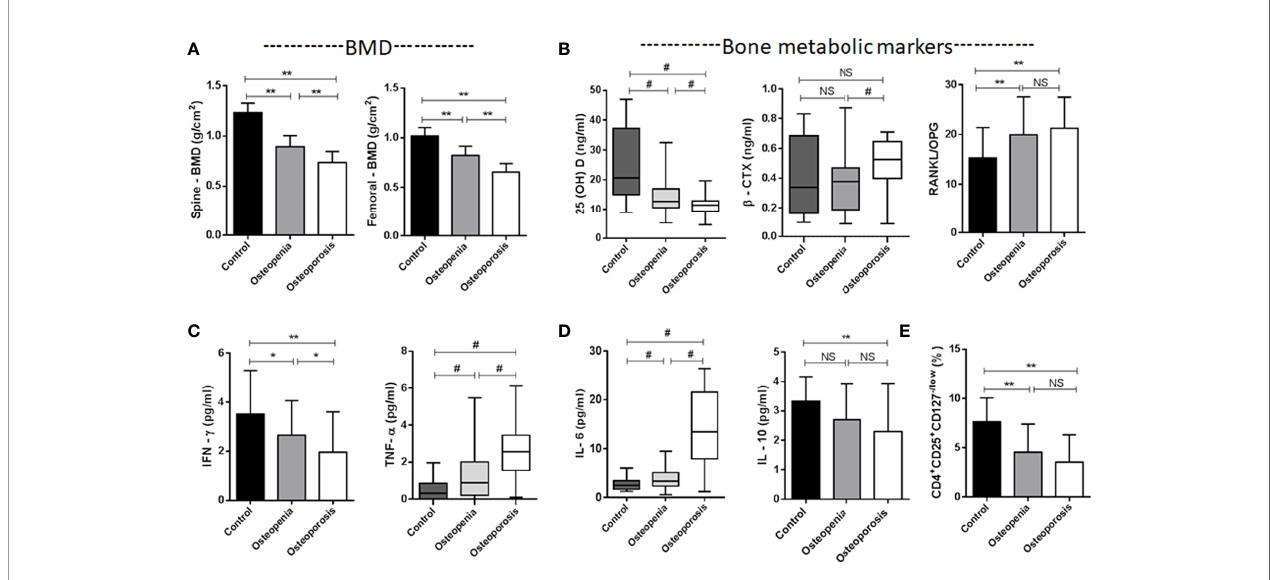
FIGURE 1 | Characteristics of the studied groups. (A) Spine L1-4 BMD and Femoral neck BMD. (B) Bone metabolic markers [25(OH)VD, b -CTX, RANKL/OPG]. (C) Plasma levels of TNF- a and IFN- g secreted by Th1. (D) Plasma levels of IL-6 and IL-10 secreted by Th2. (E) CD4 + CD25 + CD127 -/low Treg cells. * p < 0.05, ** p < 0.01, # p < 0.017 ( # p < 0.017, was considered signi fi cant, the test level needed to be adjusted for multiple pairwise comparisons of data, inspection level a ’ = inspection level a /times of comparison). NS, No statistical differences. Data are Mean± SD or Mean ±